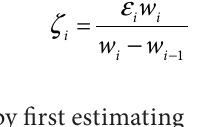
Intensive and extensive elasticities as proposed by Saez (2002)